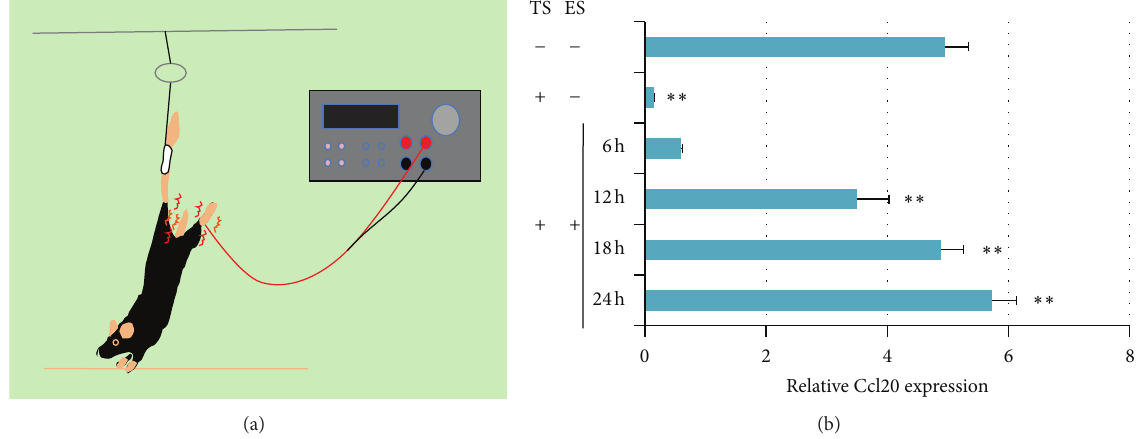
Figure 4: Neural stimulation-mediated activation of the inflammation amplifier creates a gateway into the CNS via chemokine production. Schematicillustrationofthetailsuspensionmodel(a).Astringisfastenedtotheroofofthecageataheightthatallowstheforelimbstosupport body weight but prevents the hindlimbs from touching any part of the cage. Release from gravitational stimuli caused by tail suspension (TS) results in a decrease of Ccl20 levels at the L5 dorsal venules. Electric stimulation (ES) during TS restores the levels in a time-dependent manner (b).